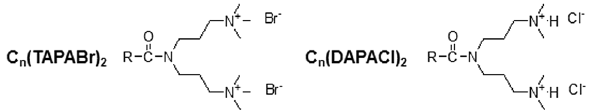
Figure 2. Chemical structures of dicephalic